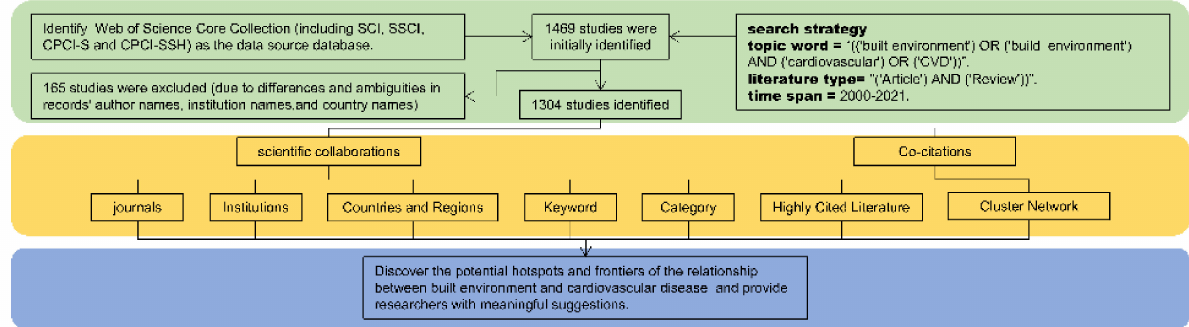
Figure 1. The flowchart of the study